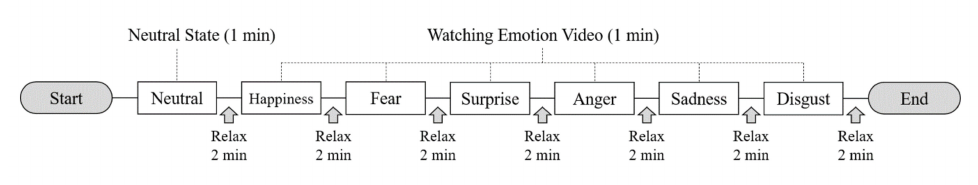
Figure 2. Experimental procedure.